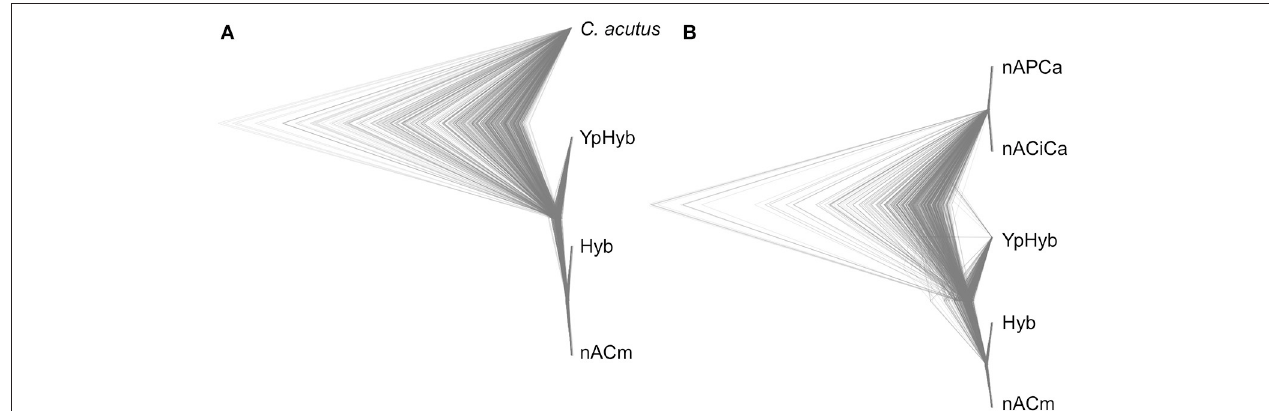
FIGURE 6 | Bayesian species delimitation with genomic data for Crocodylus moreletii , C. acutus and hybrids. Results from the Bayes Factor comparisons of alternative species models. Cladograms for the (A) four lineages hypothesis (Ln Maximum-likelihood = − 14635.35; Ln Bayes factor = − 3501.16): non-admixed C. moreletii (nACM), hybrids (Hyb), Yucatan peninsula hybrids (YpHyb) and C. acutus (Caribbean + Pacific); and (B) five lineages hypothesis (Ln Maximum-likelihood = − 14588.68; Ln Bayes factor = N/A): non-admixed C. moreletii (nACM), hybrids (Hyb), Yucatan peninsula hybrids (YpHyb), non-admixed Caribbean Islands C. acutus (nACICa), and non-admixed Pacific C. acutus